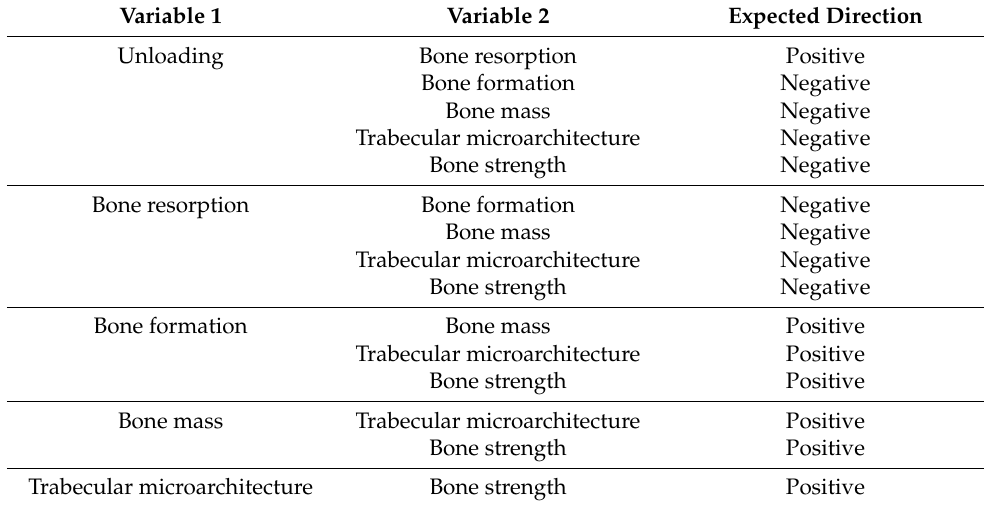
Table 2. Marginal correlations and their expected directions of association.